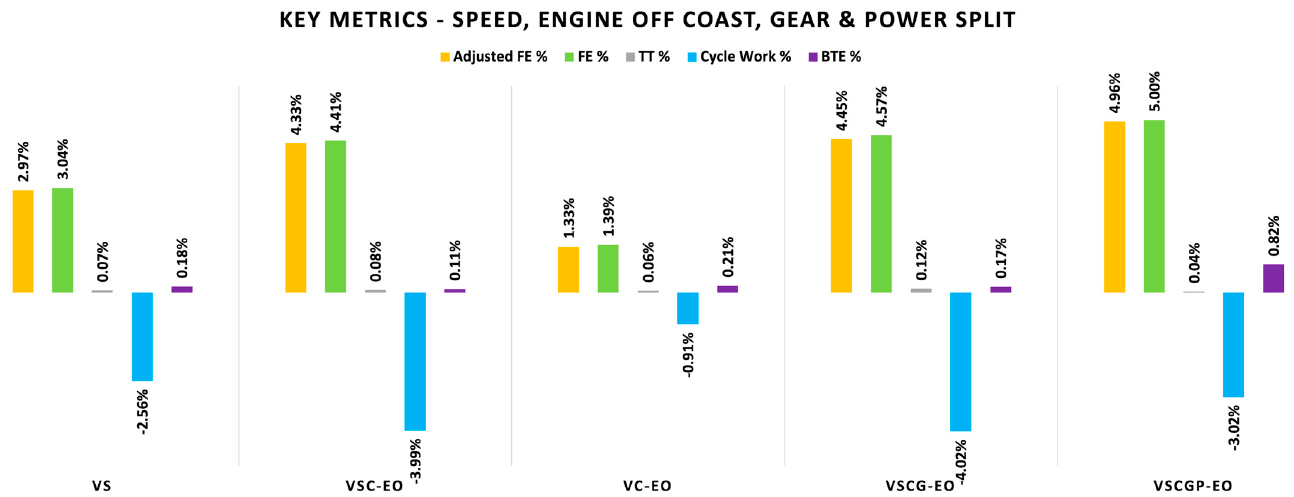
Figure 10. Key metrics showing the comparison of benefits along with cycle work and BTE for the complete set of problems including speed, coast, gear, and power split management. This scenario is with engine-off coast.